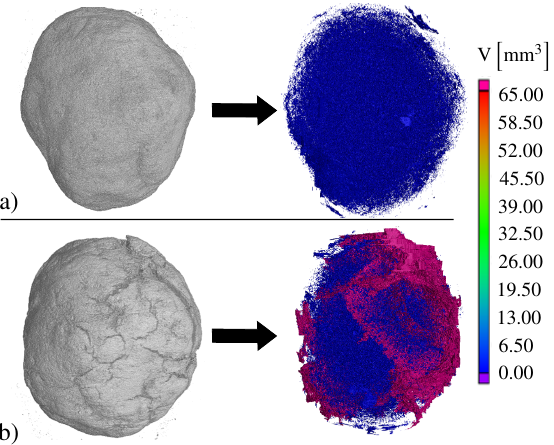
Fig. 8 µ CT image of the S1 a) complete image and blank vol- Figure 10. µCT-images of S1 ( a ) complete image and blank volume before the TGA investigations and ( b ) complete image and blank volume after 29 redox